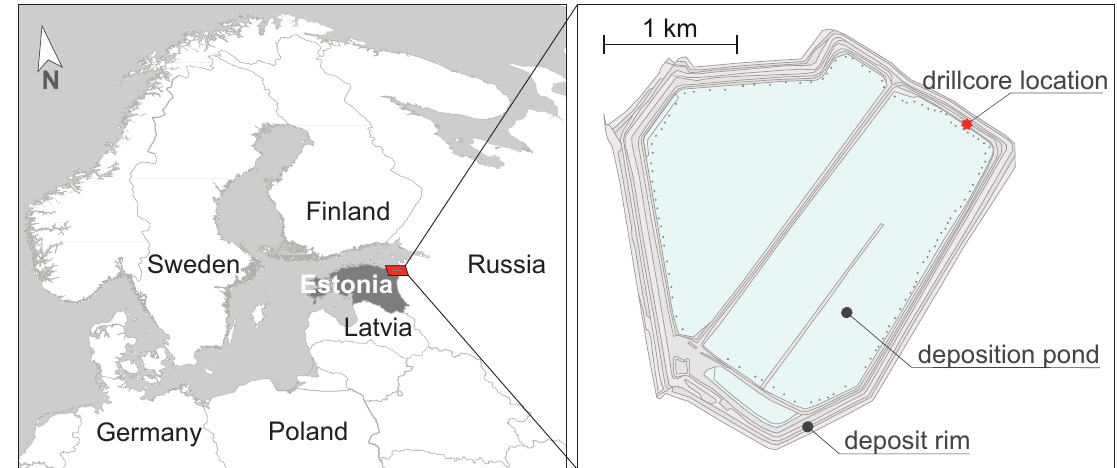
Fig. 1. Location of the ash waste